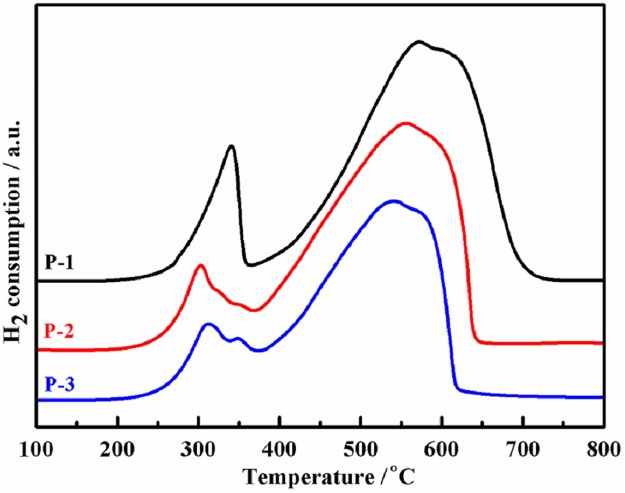
H2-TPR profiles of the precursors.